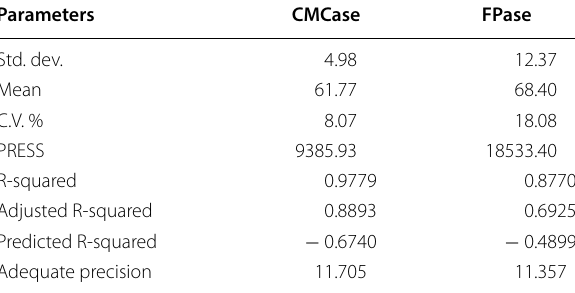
Table 3 Coefficient for determination (R 2 ) for CMCase